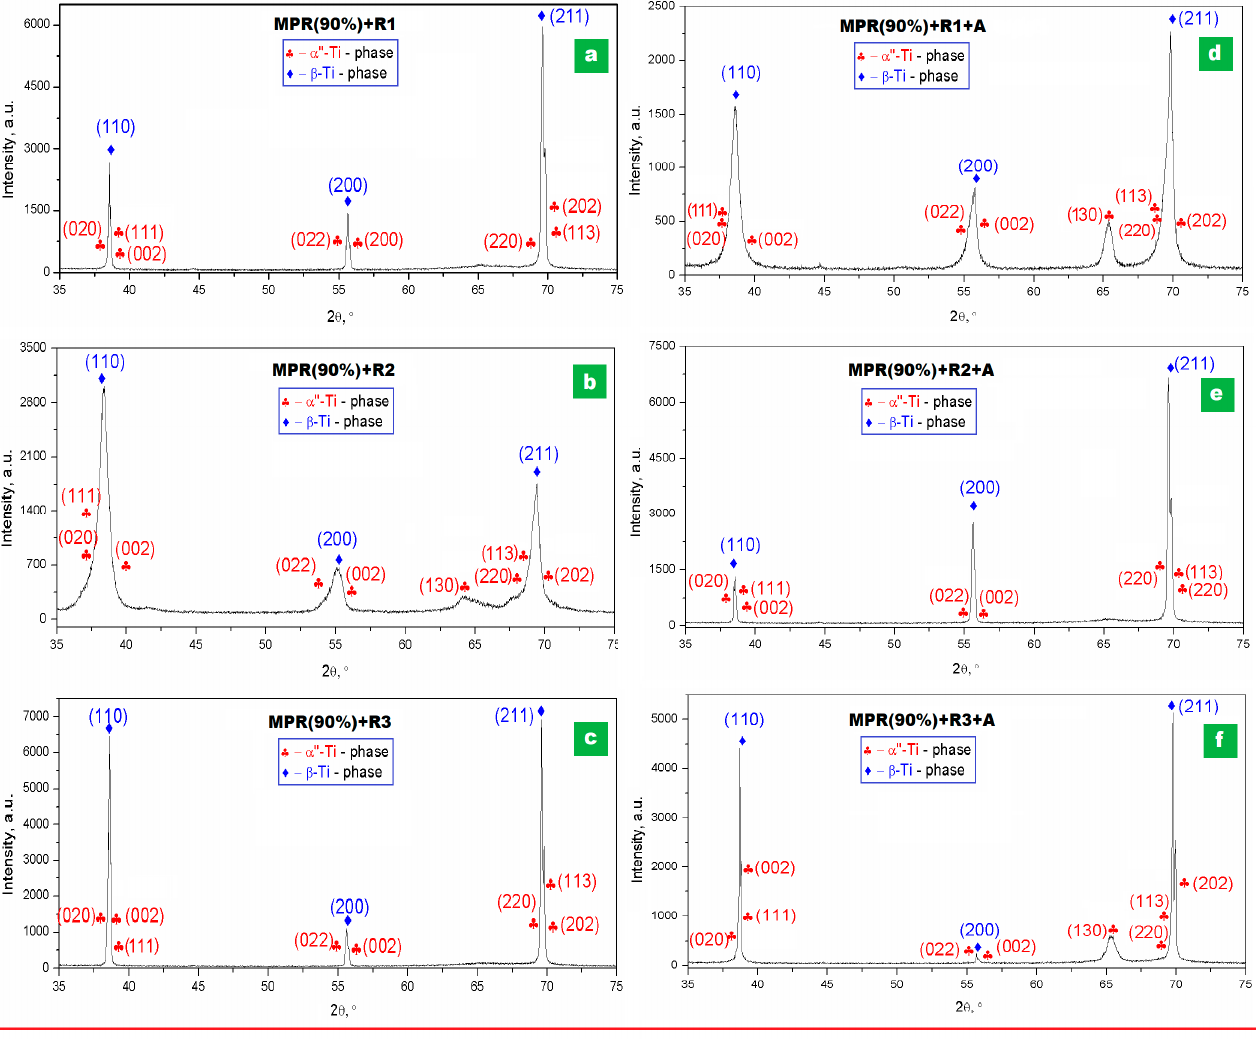
Figure 3. XRD pa tt erns of the Ti29Nb-9Ta-10Zr alloy corresponding to following stages: ( a ) MPR Figure 3. XRD patterns of the Ti29Nb-9Ta-10Zr alloy corresponding to following stages: ( a ) MPR (90%) + R1 (780 °C/5 min/w.q.); ( b ) MPR (90%) + R2 (830 °C/5 min/w.q.); ( c ) MPR (90%) + R3 (880 (90%) + R1 (780 ◦ C/5 min/w.q.); ( b ) MPR (90%) + R2 (830 ◦ C/5 min/w.q.); ( c ) MPR (90%) + R3 °C/5 min/w.q.); ( d ) MPR (90%) + R1 + A (400 °C/5 min/w.q.); ( e ) MPR (90%) + R2 + A (400 °C/5 (880 ◦ C/5 min/w.q.); ( d ) MPR (90%) + R1 + A (400 ◦ C/5 min/w.q.); ( e ) MPR (90%) + R2 + A min/w.q.); ( f ) MPR (90%) + R3 + A (400 °C/5 min/w.q.). (400 ◦ C/5 min/w.q.); ( f ) MPR (90%) + R3 + A (400 ◦ C/5